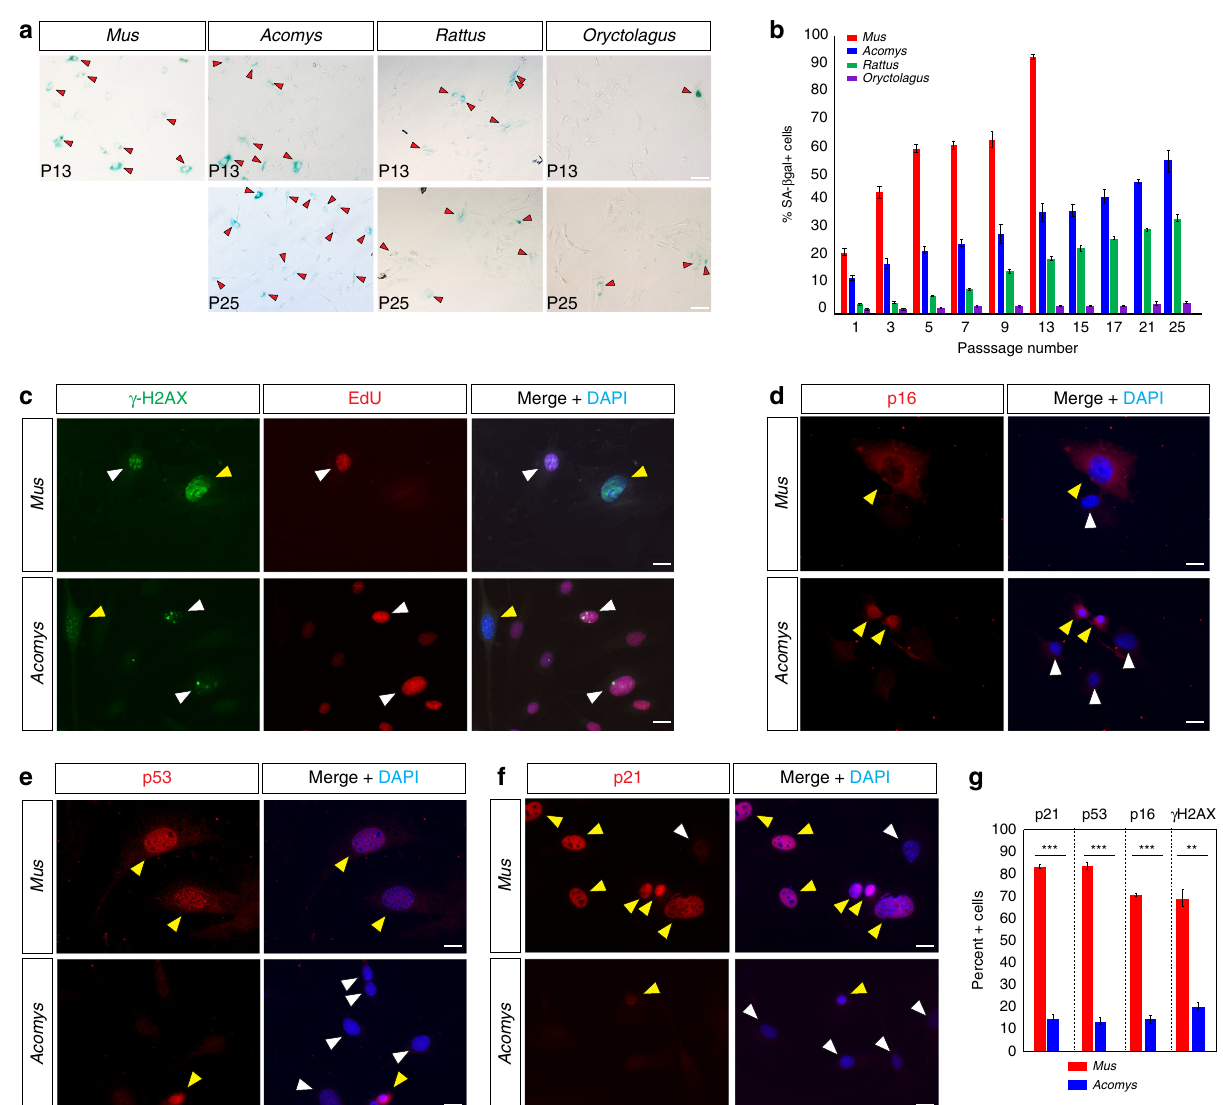
Fig. 2 In vitro resistance to senescence is not restricted to regenerating mammals. a , b In line with proliferative ability, cells cultured at 3% O 2 were more resistant to cellular senescence. Percent SA- β gal + cells were measured in Mus , Acomys, Rattus, and Oryctolagus ( n = 4 – 5 species) at progressive passages. Mus cells senesced at P13 and > 90% of cultures were SA- β gal + . There were signi fi cantly more SA- β gal + cells compared to Acomys (~37%) , Rattus (~22%) and Oryctolagus (~4%) (P13 Tukey-HSD, Mus vs. Acomys , t = − 23.81, P < 0.0001; Mus vs. Rattus, t = 29.29, P < 0.0001 Mus vs. Oryctolagus, t = 39.98, P < 0.0001). Red arrows indicate SA- β gal + cells ( a ). c Acomys and Mus fi broblasts ( n = 3/species) from P2 co-labeled with γ -H2AX and EdU to differentiate senescent cells. Yellow arrows indicate nuclei positive for γ -H2AX and EdU and white arrows represent nuclei positive for EdU only. d – f P2 Acomys and Mus fi broblasts ( n = 3) labeled with p16 ( d ), p53 ( e ), and p21 ( f ), and DAPI. Yellow arrows show marker positive cells while white arrows show negative cells. g Quanti fi ed cell counts for panels c – f . There were signi fi cantly more senescent cells in Mus cultures positive for: γ -H2AX + , p21 + , p53 + , and p16 + (Supplementary Table 4). Representative scale bars in panels a and c – f = 50 µ m and 20 µ m, respectively. *** P < 0.0001, ** P < 0.001, * P < 0.05. Error bars = S.E.M. Source data are provided as a Source Data fi